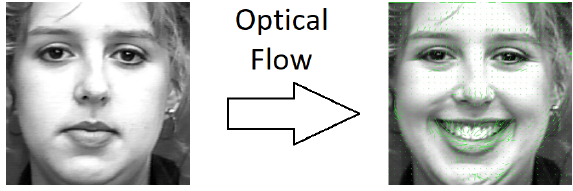
Figure 14. OF of a sequence from the CK+ database.